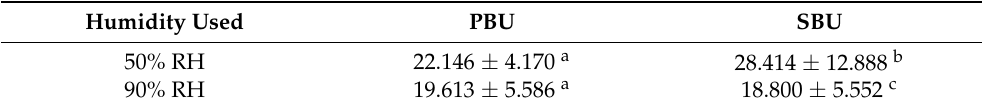
Table 3. Mean ± SD of µ TBS (MPa) for study groups. Groups recognized by dissimilar symbols are statistically different ( p <